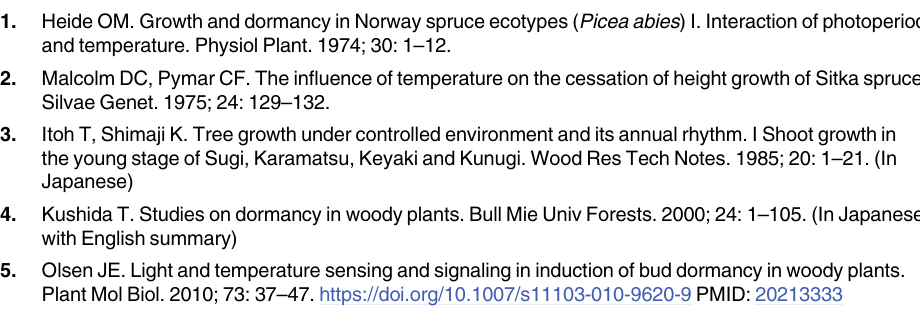
S1 Table. Primers used for quantitative RT-PCR in this study. � Reference [27]. S2 Table. Top-scoring targets for principal component 1. SD-up, SD-down, LT-up, and LT- down indicate SD up-regulated targets, SD down-regulated targets, LT up-regulated targets, and LT down-regulated targets, respectively. S3 Table. Day length- and temperature-regulated